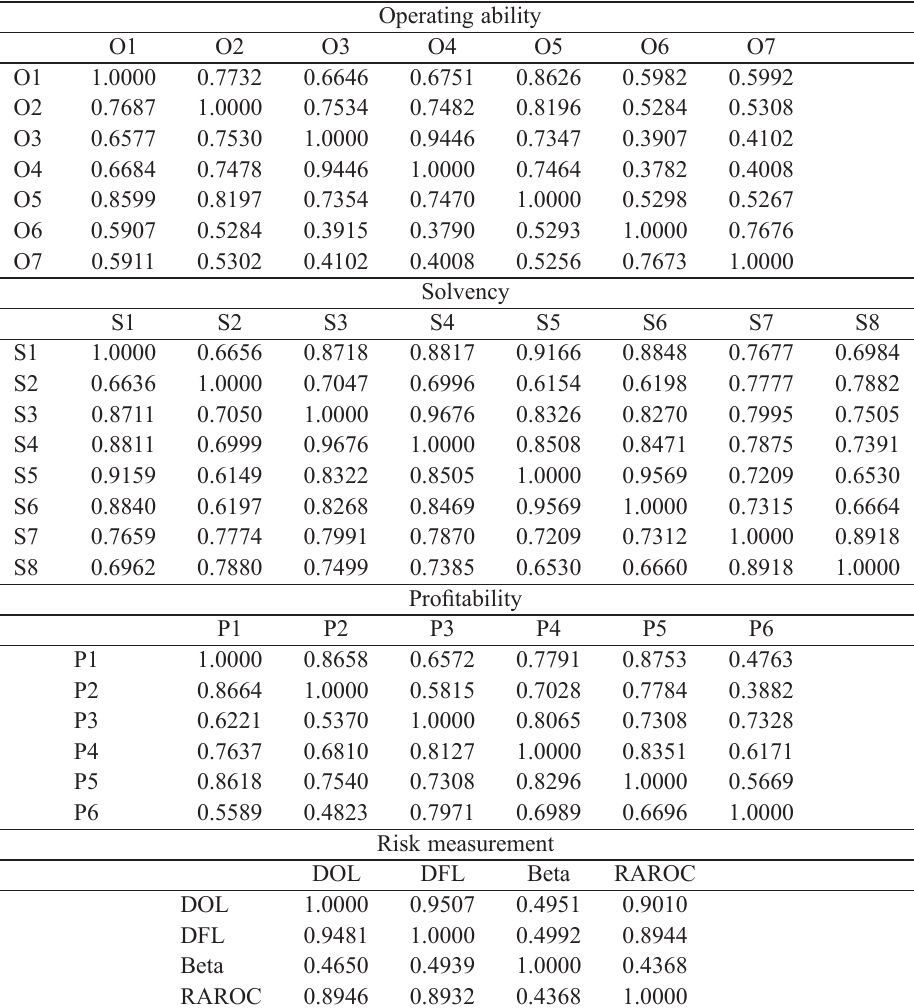
Table 2. The results of the grey relational